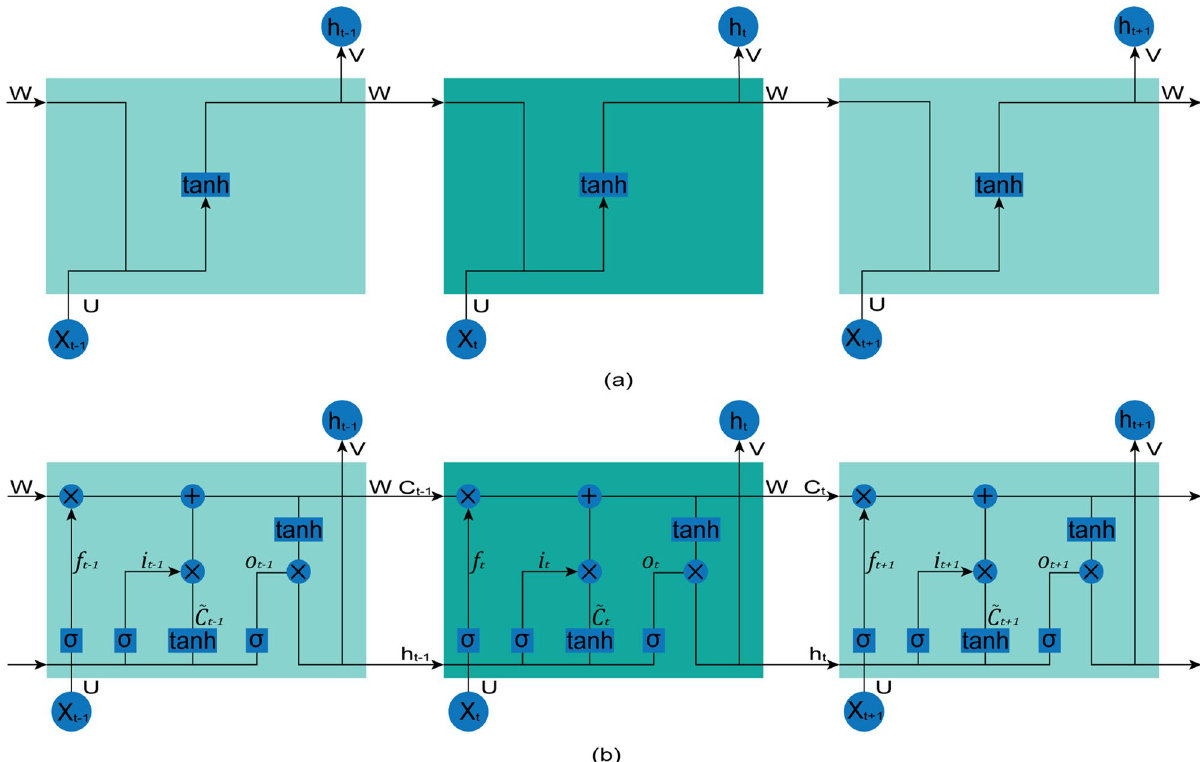
Figure 1. ( a ) Chain-like structure of the RNN. Because of the connections between hidden units, information can be passed from one time step to the next. ( b ) A graphical representation of the LSTM recurrent network with the memory cell